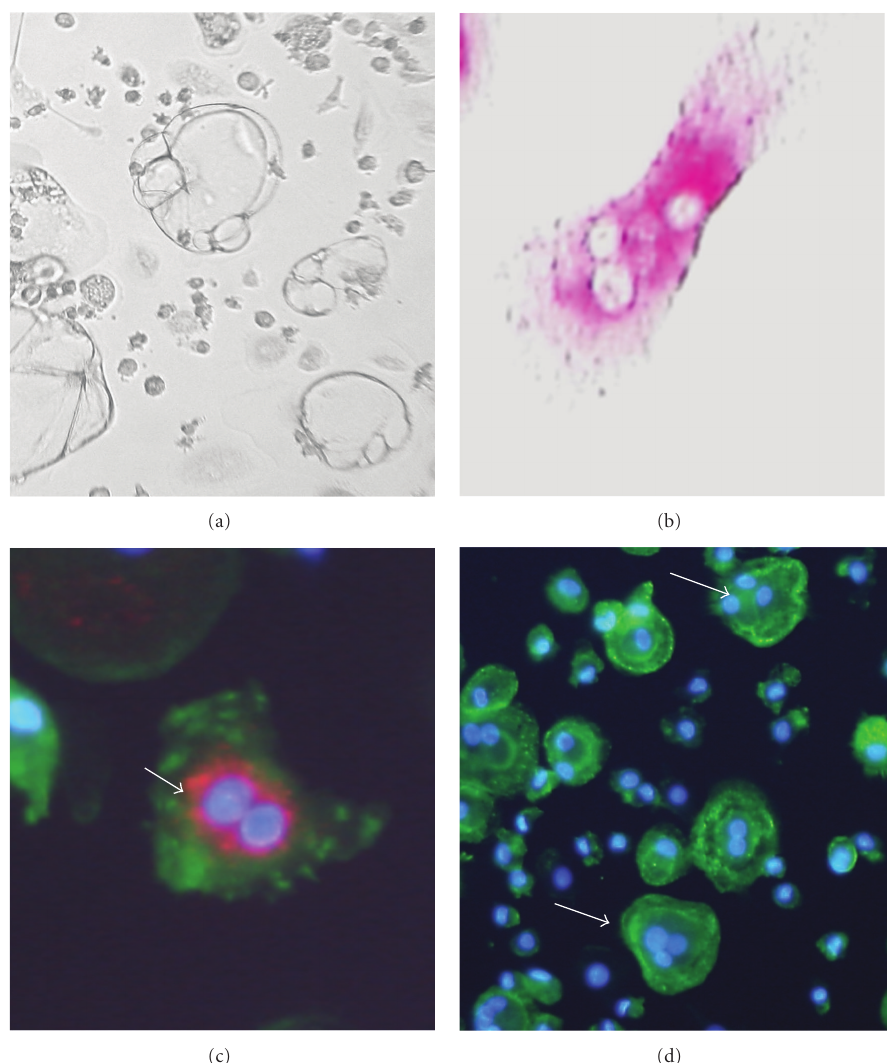
Figure 1: Typical morphological appearance of osteoclasts: after 10 to 14 d in culture (data from day 12 are shown) giant cells were seen ((a); × 400), which expressed TRAP (b), cathepsin K (c) (shown in red, thick arrow), had multiple nuclei (blue) (c), (d), and the typical ring-like distribution of actin (green). Images as shown in (d) were used for